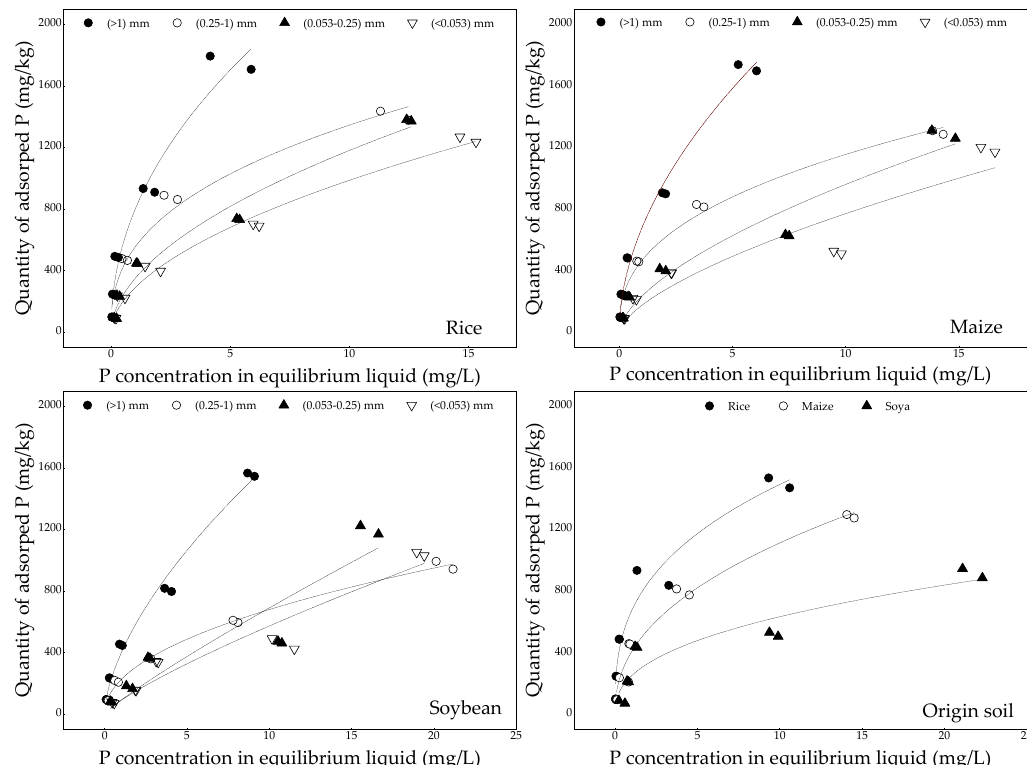
Figure 4. Variation in the quantity of adsorbed phosphorus with phosphorus concentration in equilibrium liquid. Table 2. The results of adsorption isotherm simulation.